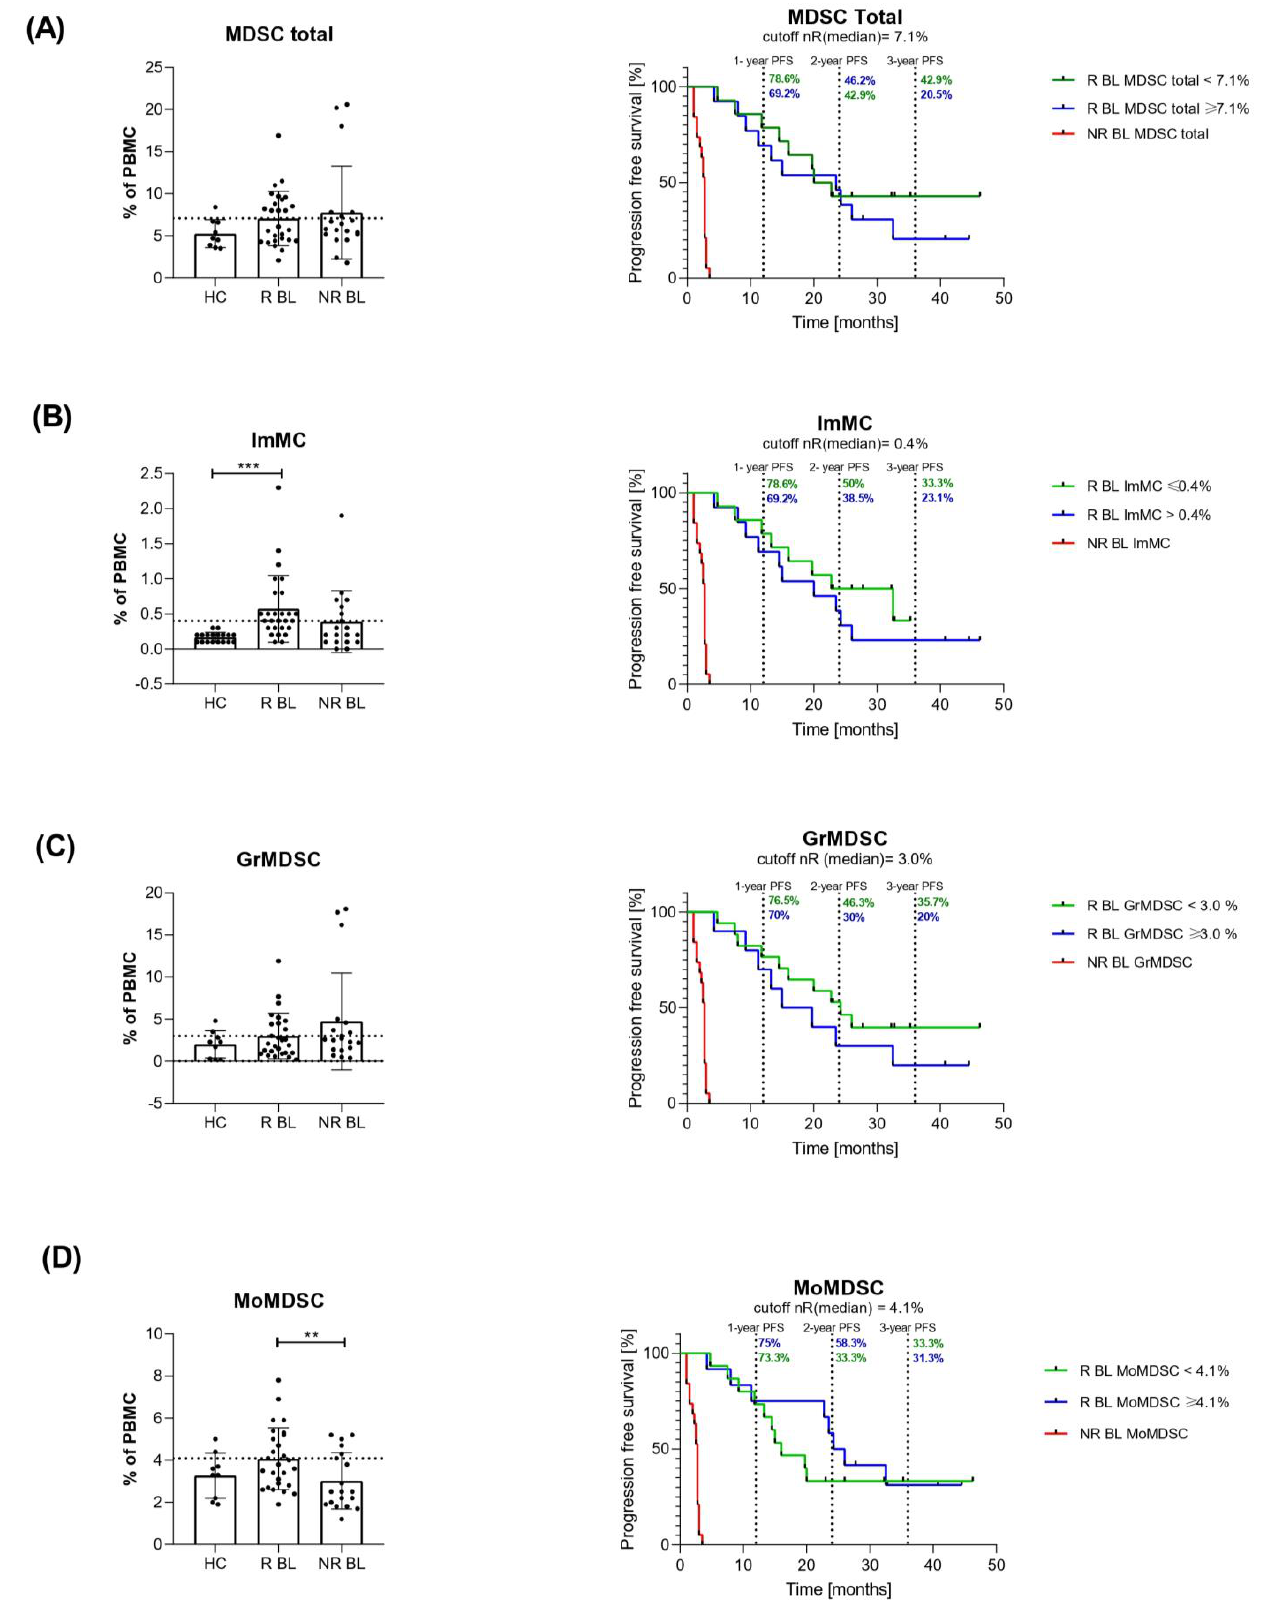
Figure 2. Myeloid suppressor cell (MDSC) levels prior to immunotherapy. Levels of circulating MDSC total, ImMC, GrMDSC and MoMDSC were evaluated as % of PBMC and analysed using Kruskal-Wallis and t-Student tests. Occurrence of the response to anti-PD-1 therapy was evaluated